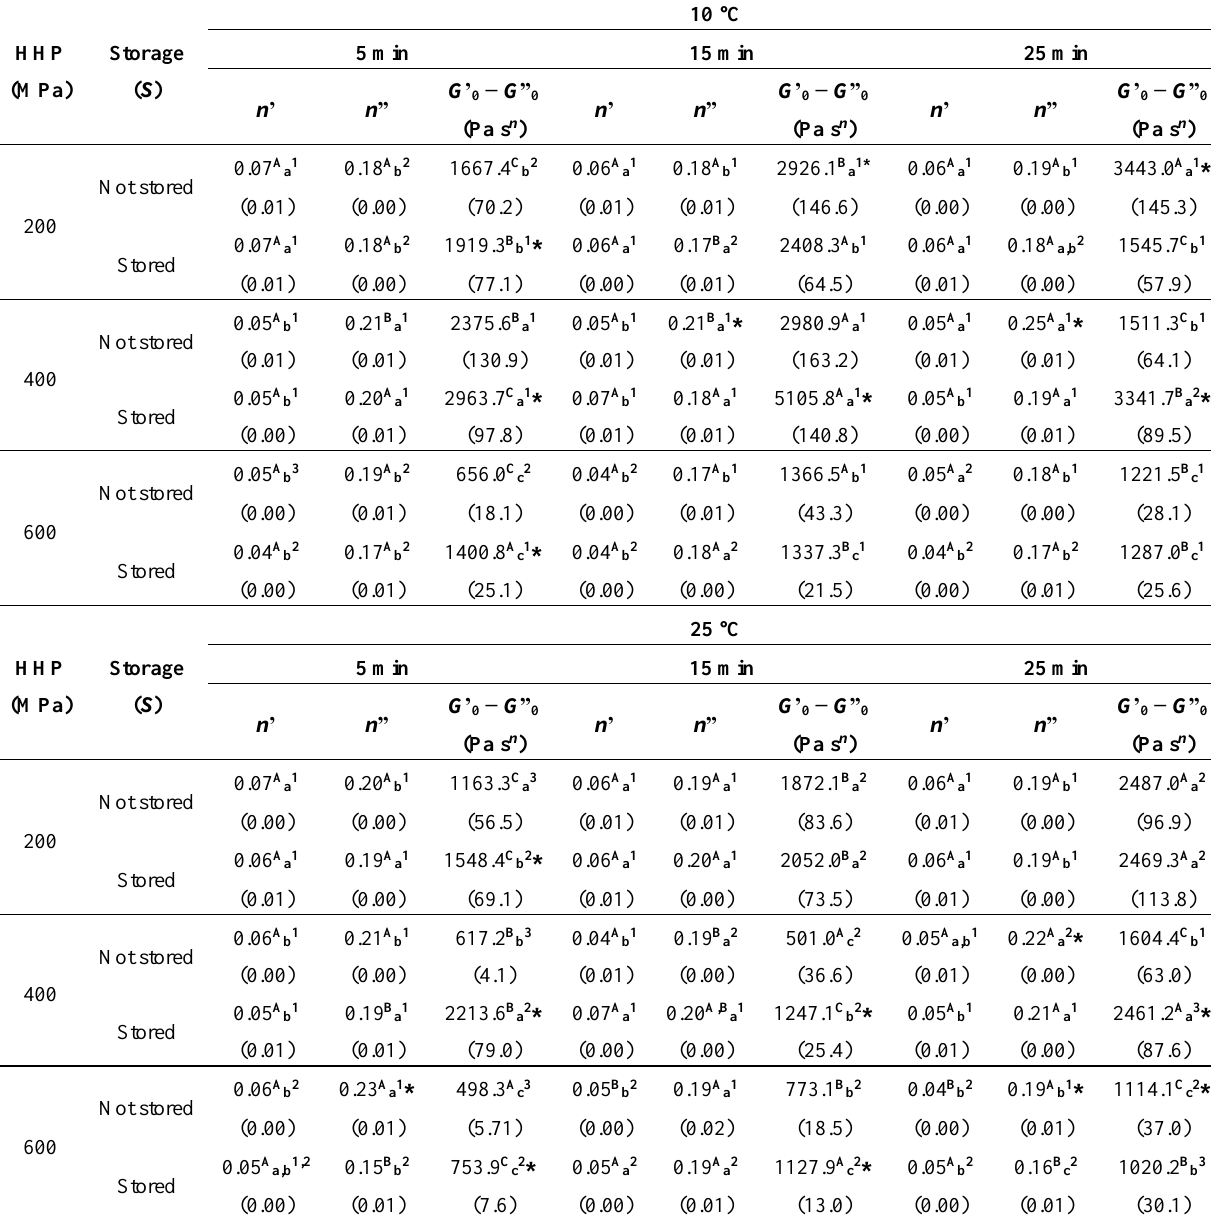
Table 3. Mean values of power law parameters ( n ’, n ”, and G ’ 0 – G ” 0 at 1 Hz) from Equations (1) and (2) of chickpea flour gel heat-induced at 75 °C for 15 min derived from mechanical spectra after cooling to 25 °C in samples without and with storage for the different pressures (200, 400, and 600 MPa) and treatment temperatures (10 and 25 °C) applied for 5, 15, and 25 min, and for untreated